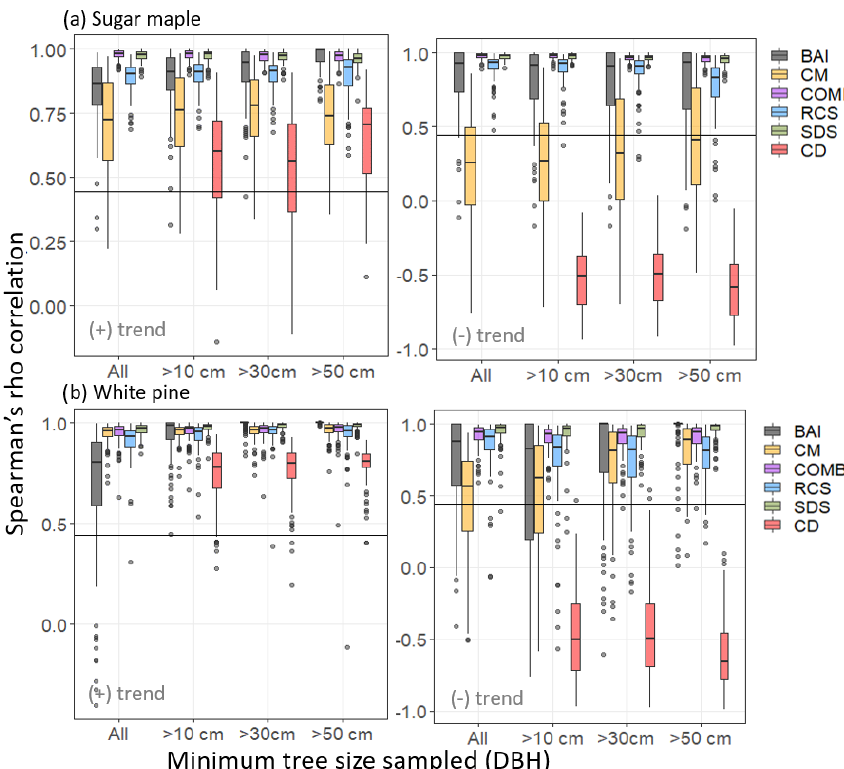
Figure 3. Spearman’s rho correlation between chronologies produced by each of the five standardization methods and the imposed positive (left column) or negative (right column) logistic trend in SORTIE-simulated (a) sugar maple and (b) white pine tree ring data. Correlation distribution created by bootstrap resampling 60 trees (rep = 100) from SORTIE-simulated tree populations. The horizontal axis denotes minimum tree size (DBH) thresholds for sampling from the population. Horizontal lines indicate threshold for significant Spearman’s rho ( a = 0 . 05) for correlation between chronologies and the imposed